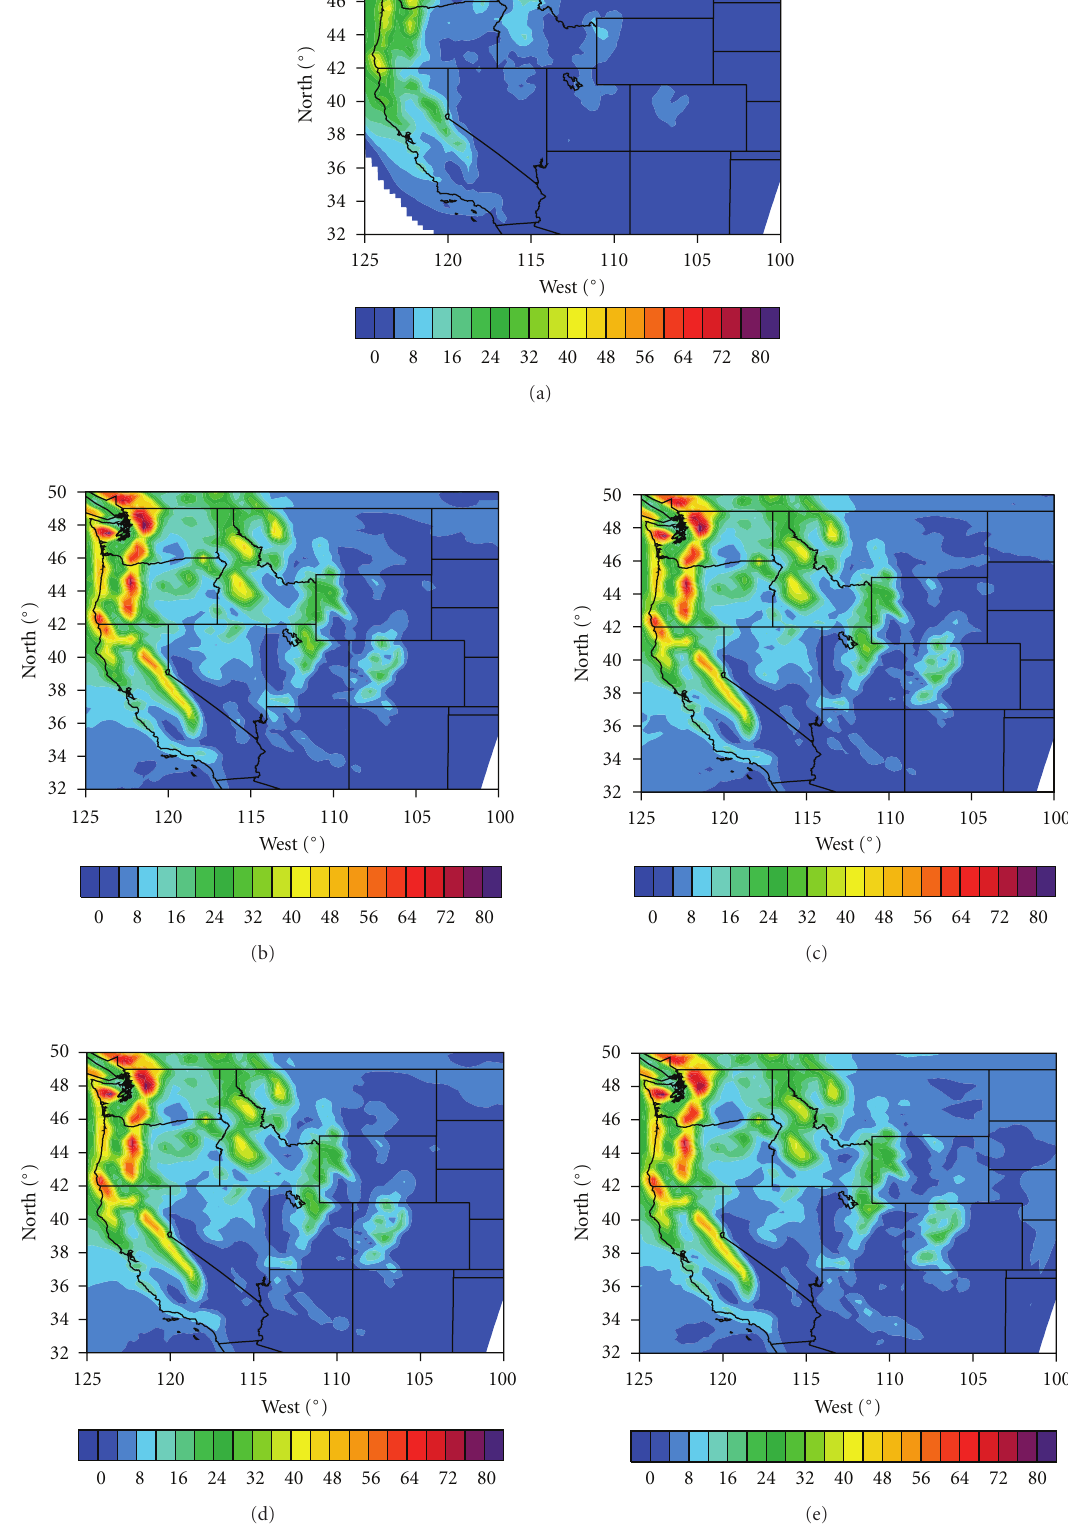
Figure 3: The geographic distribution of observed and WRF-simulated monthly winter precipitation (Unit: mm) averaged over November 1995 through March 1996. (a) Observations; (b) CLM3; (c) Noah; (d) RUC; (e)